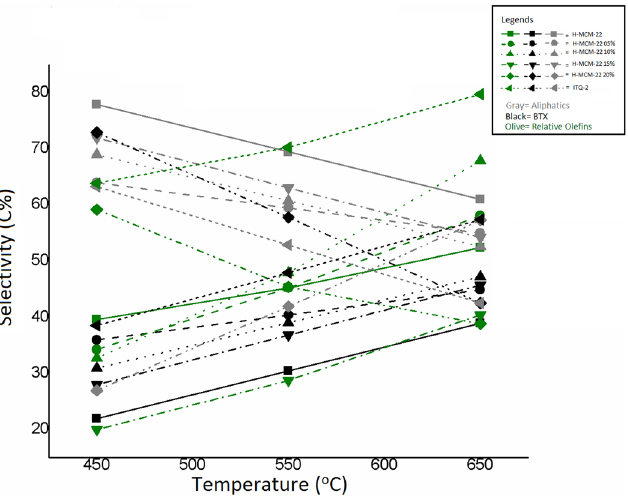
Figure 5. Effect of reaction temperature on the selectivity of products for catalytic cracking of n-hexane over prepared catalysts at different temperatures of 450 °C, 550 °C, and 650